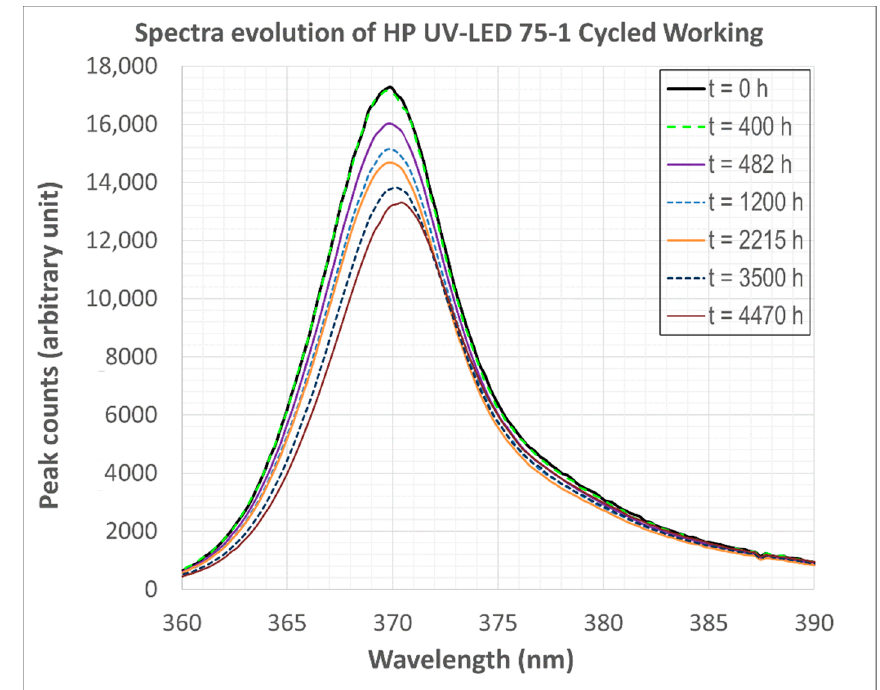
Figure 5. Graphic of the spectrometric wavelength versus time of UV-A LED 75-1 in cycled working mode at T a = 75 °C .